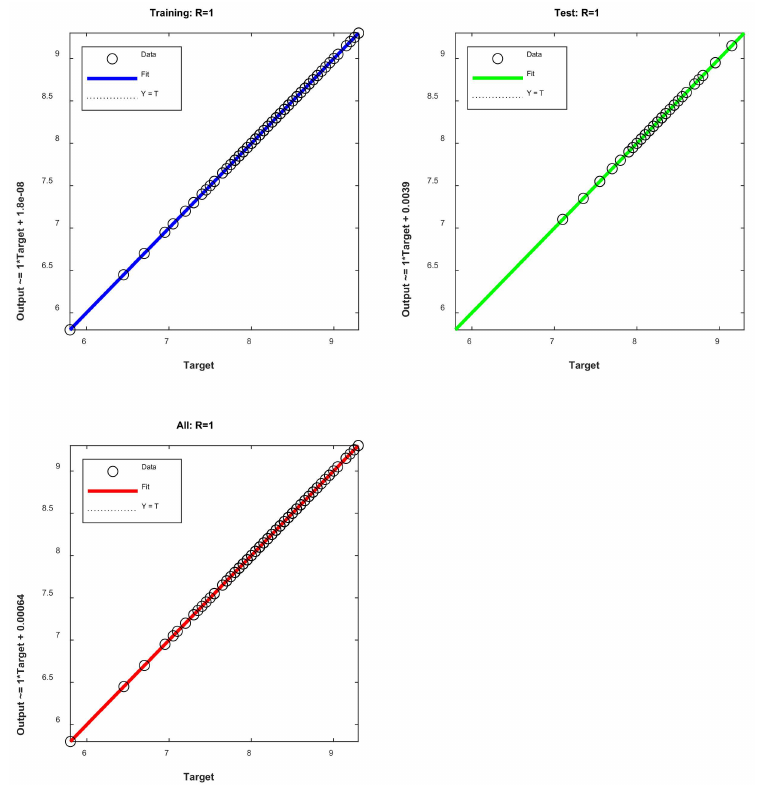
Figure 22. BRANN TLM CA50 model